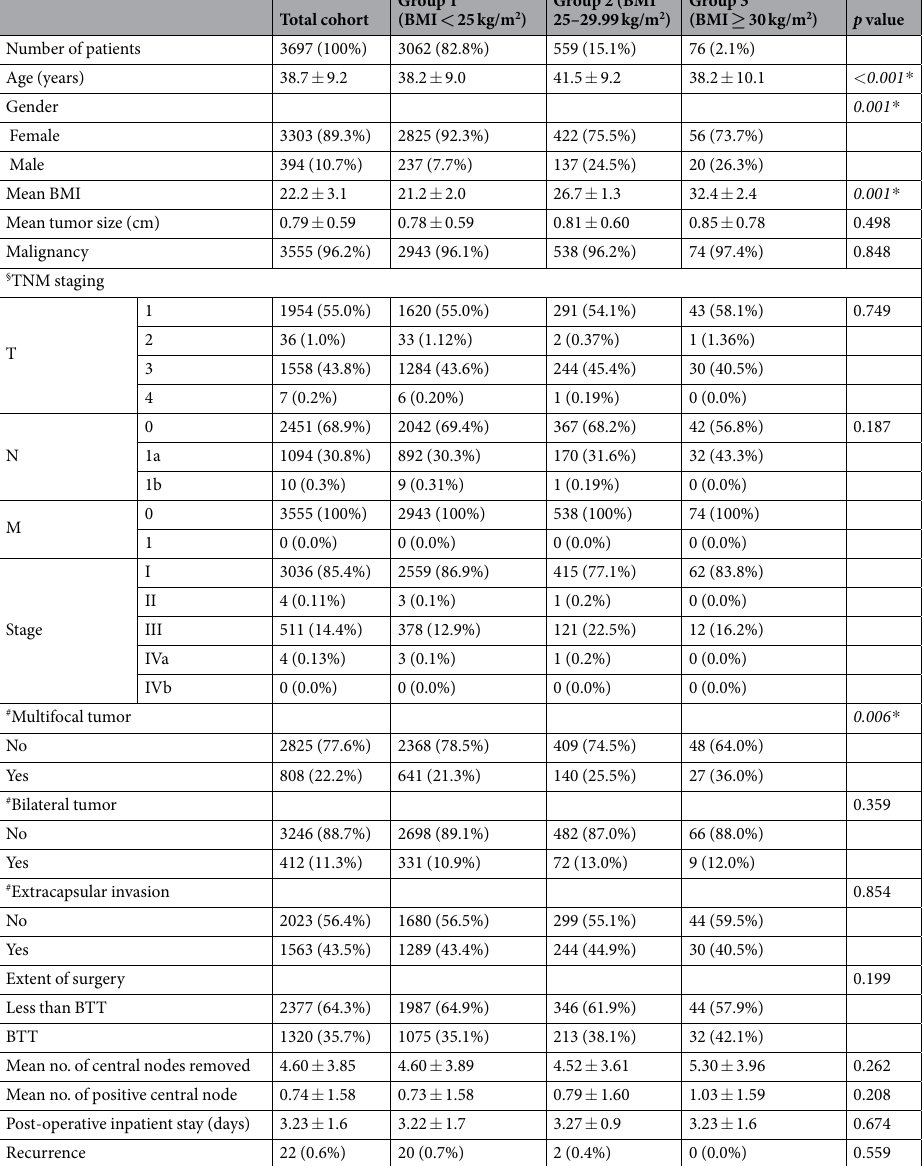
Table 1. Patient demographics and clinicopathological factors. BMI, body mass index; BTT, bilateral total thyroidectomy; § AJCC 7 th Edition/TNM Classification System for Differentiated Thyroid Carcinoma; # Data not available for the entire cohort; * statistically significant at p <